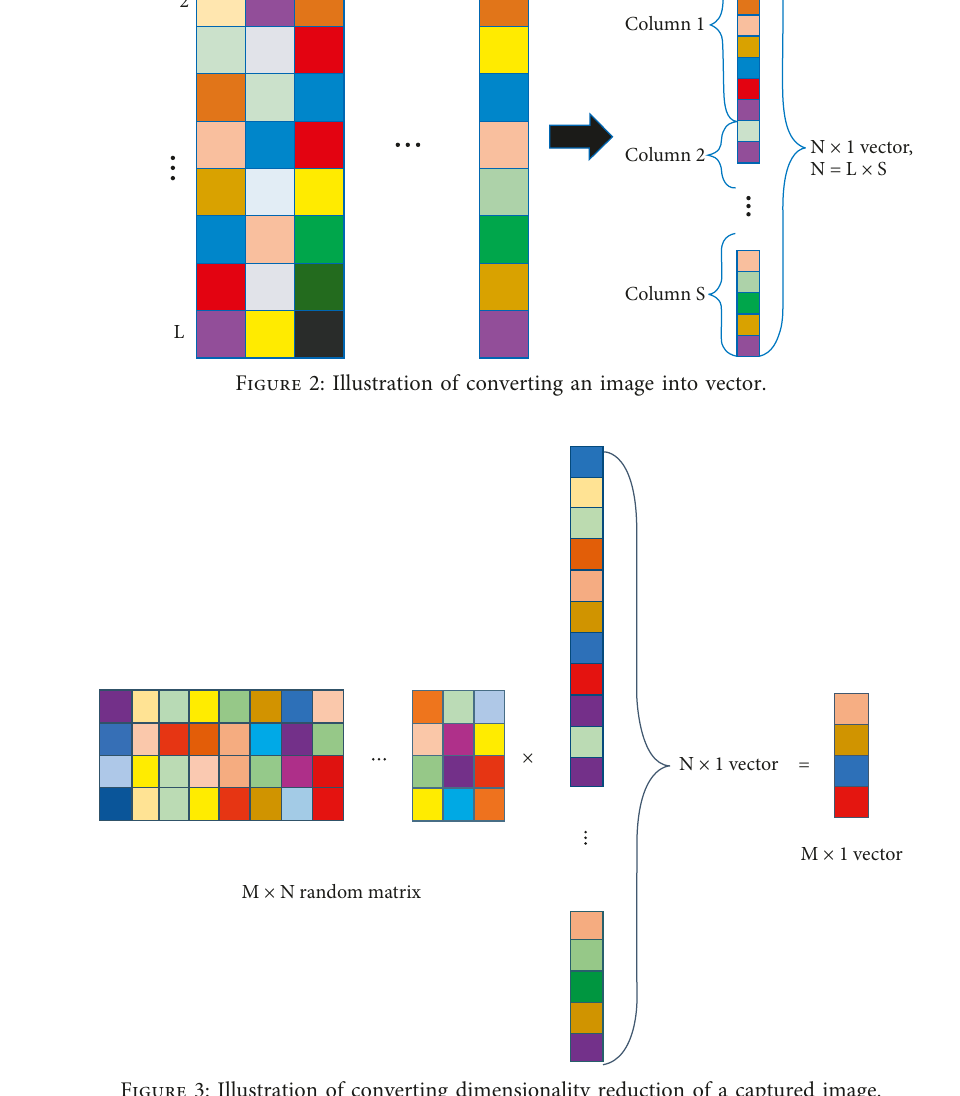
Figure 3: Illustration of converting dimensionality reduction of a captured